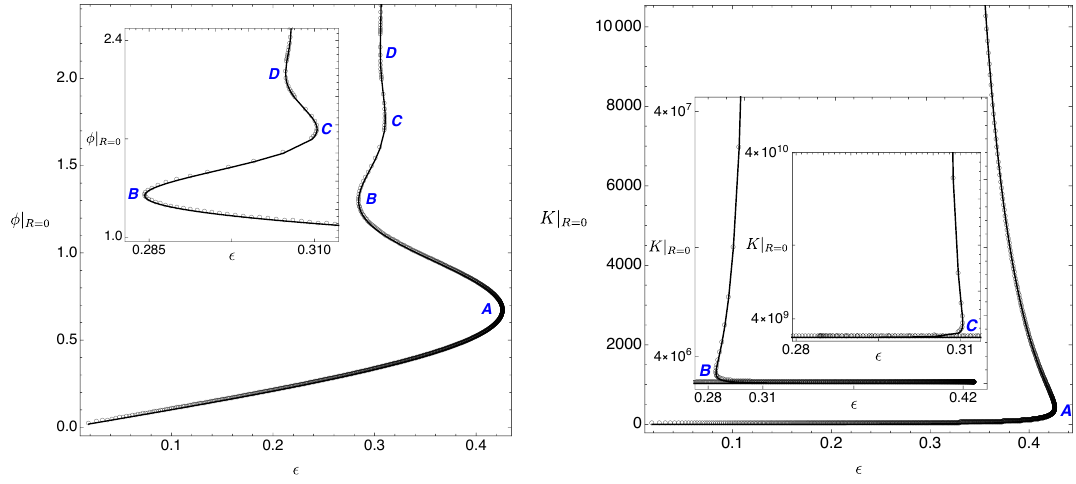
Figure 5 . Main soliton family with e = 0 . 23 ( e < e γ ). Left panel: as we ramp up the value of the amplitude (cid:15) ≡ φ 0 (1) the core value of the scalar field φ is increasing seemingly without bound. The inset plot zooms in the damped oscillations around the turning points B, C, D . Right panel: Kretschmann invariant at the origin as a function of (cid:15) . The turning points A , B , C , D are seeing a substantial increase in the curvature as we go from one to the next. This is despite the fact that they lie close to each other in the phase diagram. The inset plots zoom in around the point B and then around the point C to be able to show more clearly the large growth that K experiences (note the different scales in which